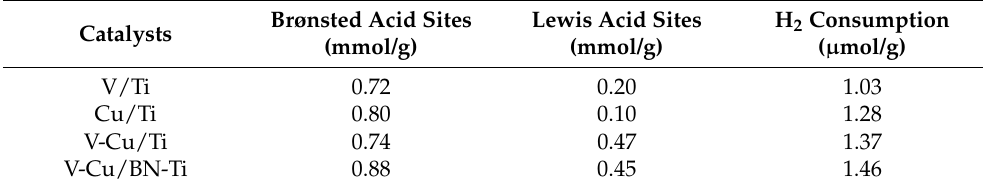
Table 2. NH 3 desorption and H 2 consumption with regard to the acidity properties of the synthe- sized catalysts.